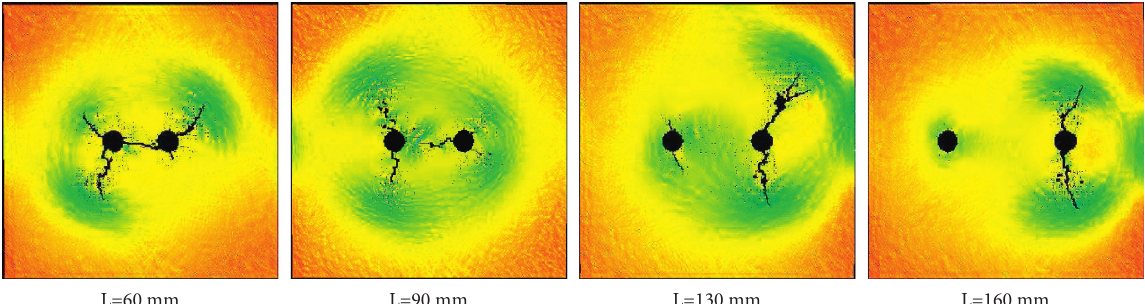
Figure 10: Morphology of hydraulic fractures with different wellbore spacing ( m � 2, K � 1).